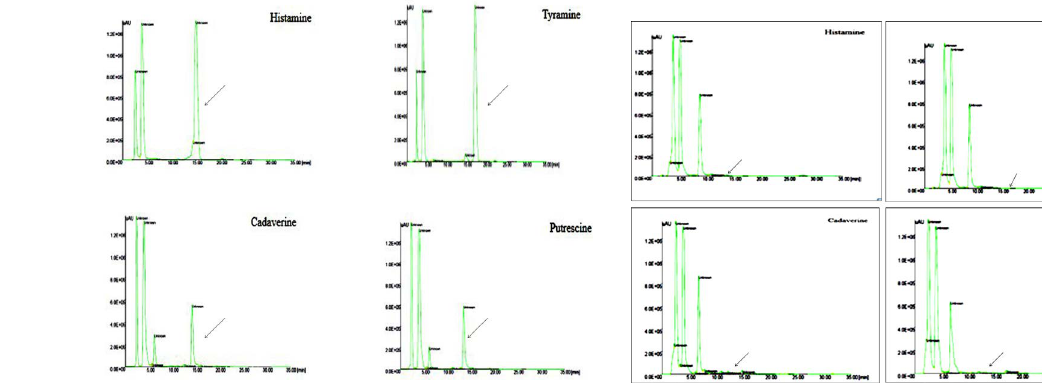
Fig. 8. HPLC Chromatogram of BAs complete degradation of histamine, tyramine and partial degradation of cadaverine and putrescine by L.